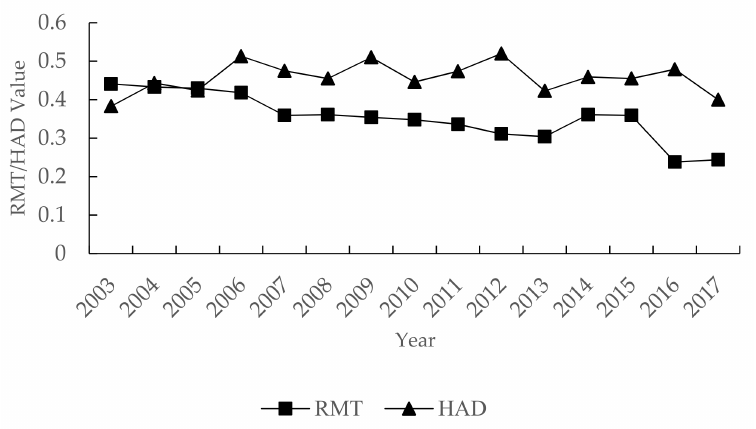
Figure 4. Evolution of RMT and HAD Global Moran’s